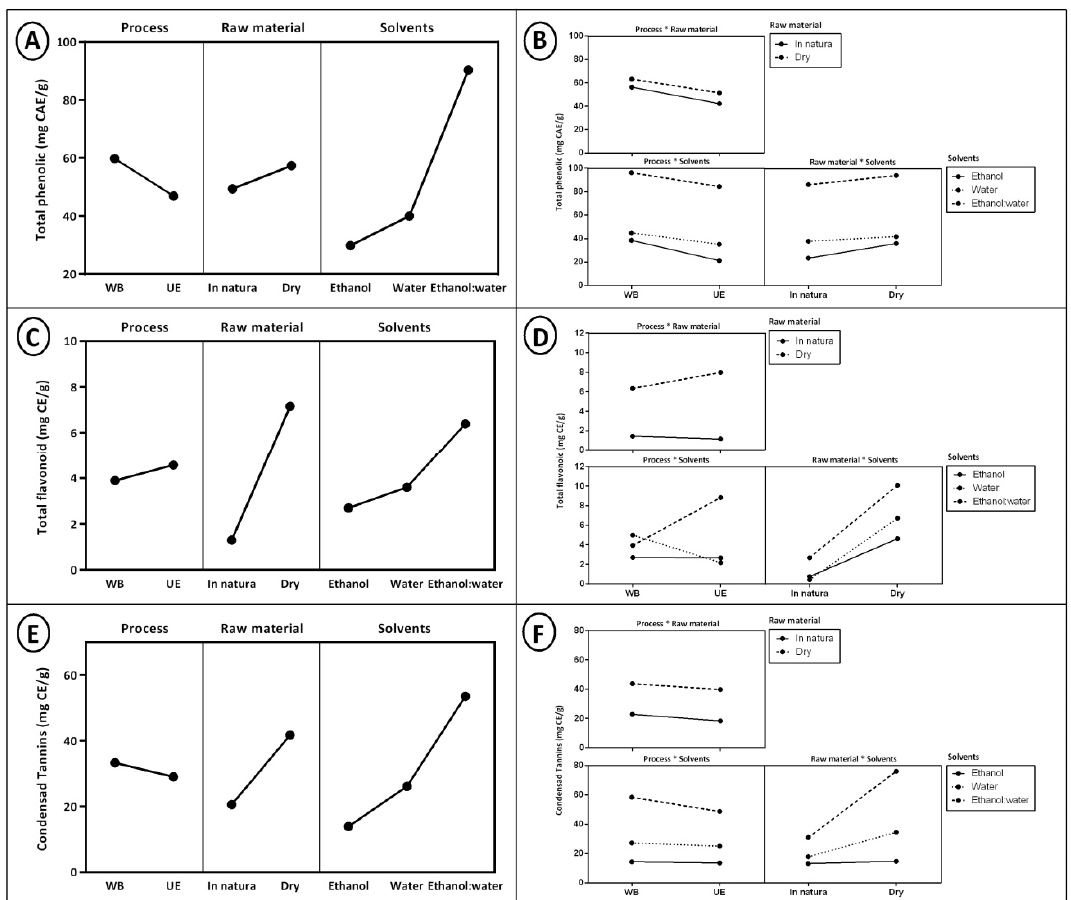
Figure 2. ( A ) Effects of extraction variables for total phenolic. ( B ) Effects of interaction between extraction variables for total phenolic. ( C ) Effects of extraction variables for flavonoids. ( D ) Effects of interaction between extraction variables for flavonoids. ( E ) Effects of extraction variables condensed tannins. ( F ) Effects of interaction between extraction variables for condensed tannins.